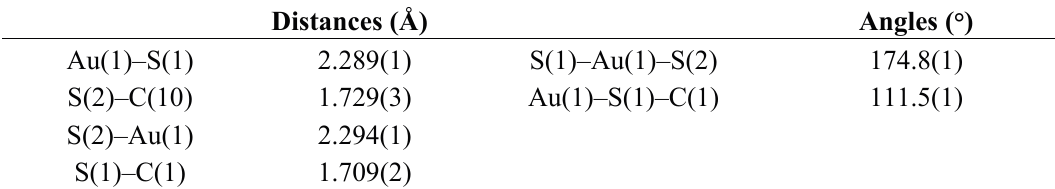
Table 2. Selected bond lengths (Å) and angles (°) for 2